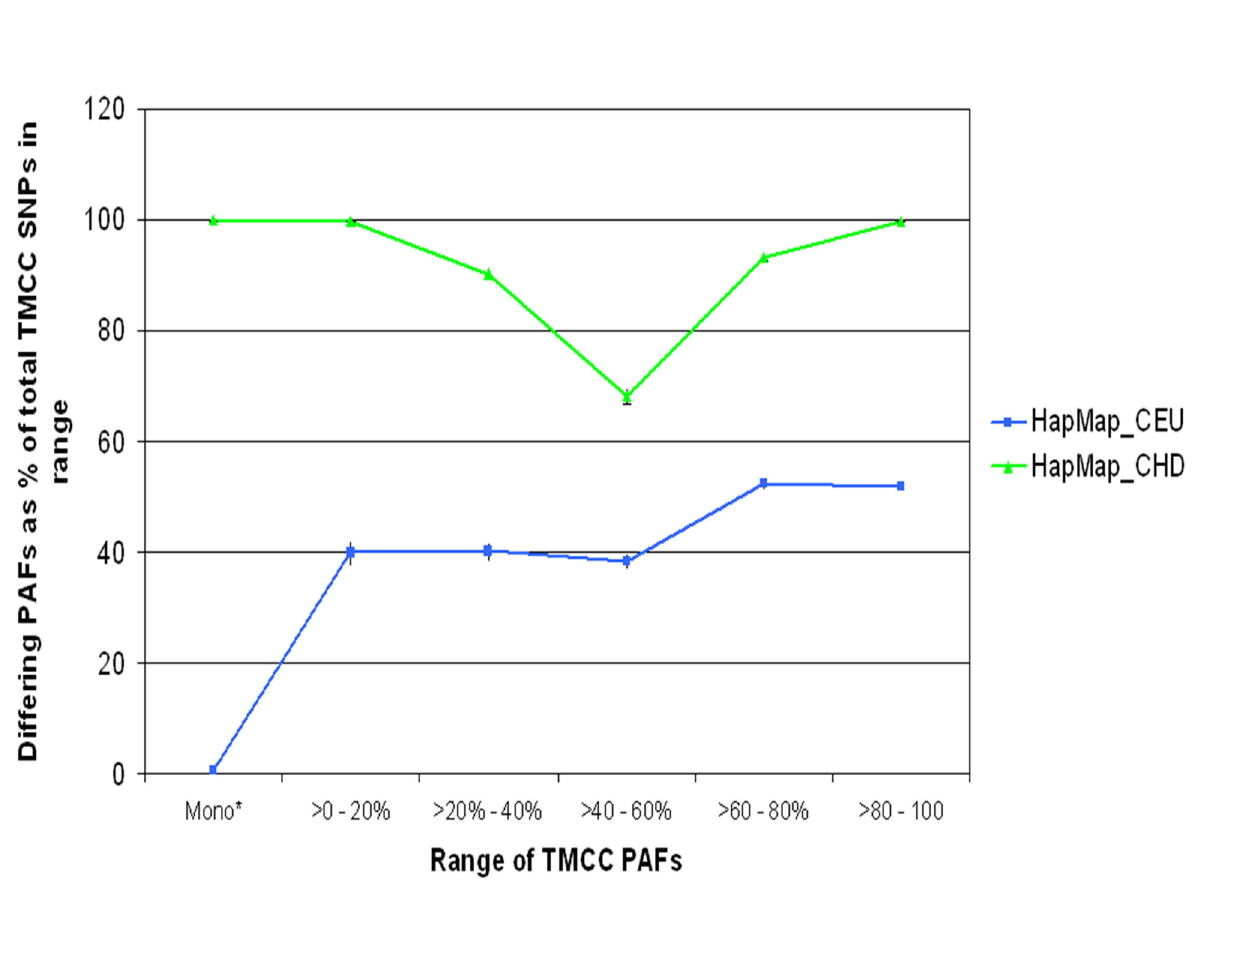
Figure 3. The number of SNPs in each TMCC prevalence range with a statistically significant different PAF than HapMap CEU or CHD